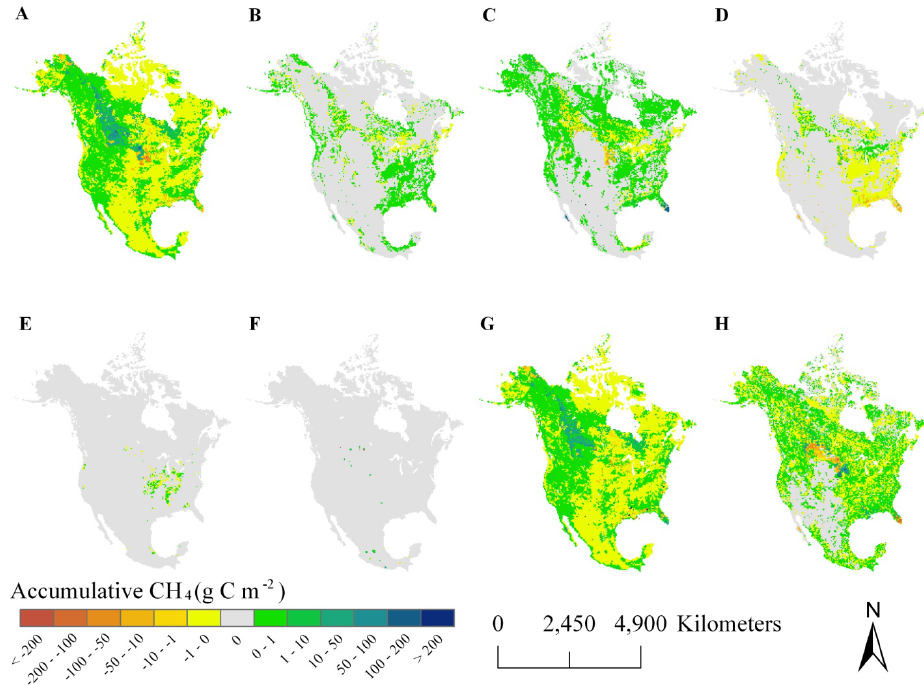
Fig. 4. Factorial contributions to the spatial variations in accumulated CH 4 flux over North America from 1979 to 2008 ( (A) : climatic variability; (B) : N deposition; (C) : CO 2 ; (D) : O 3 pollution; (E) : N fertilizer application; (F) : land conversion; (G) : all combined; (H) : interaction).